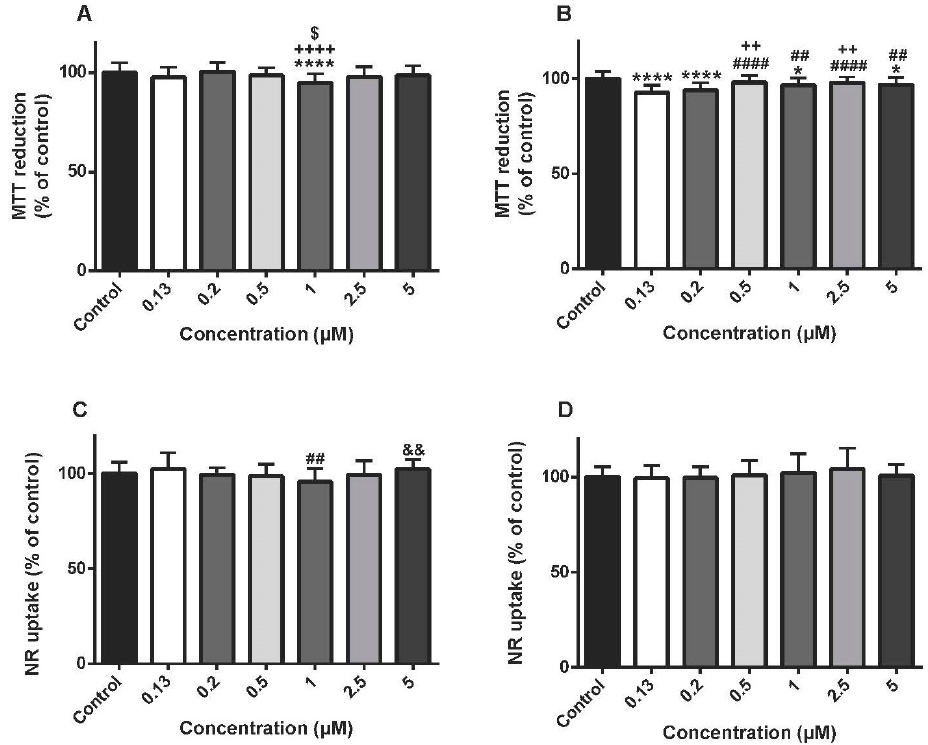
Figure 3. Mitochondrial and lysosomal dysfunction evaluated by the MTT reduction assay ( A , B ) and the NR uptake assay ( C , D ), respectively, in differentiated H9c2 cells incubated with 0.13, 0.2, 0.5, 1, 2.5, 5 μ M of cyclophosphamide (CYA) for 24 ( A , C ) and 48 h ( B , D ). Results are presented as mean ±